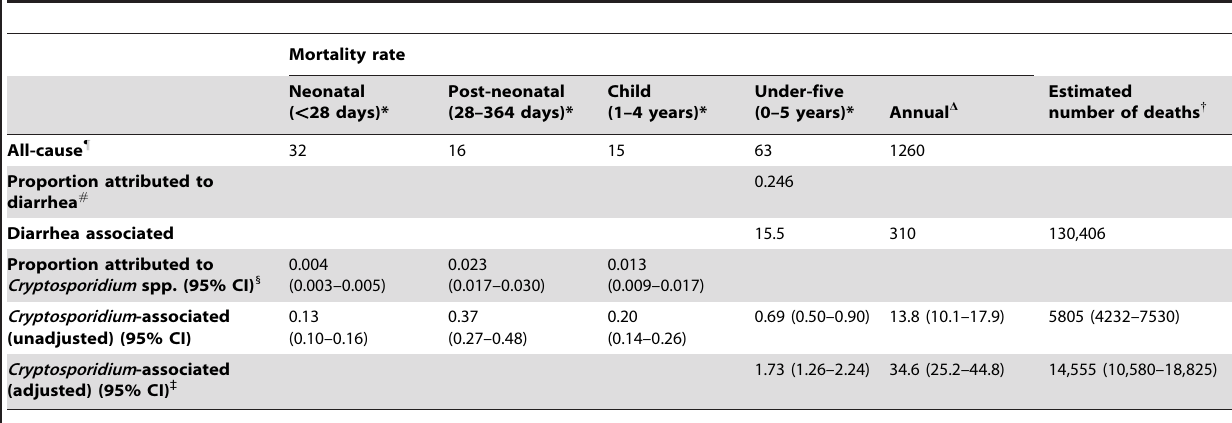
Table 4. Rates and number of deaths due to all-cause diarrhea and Cryptosporidium -associated diarrhea in Indian children , 2 years of